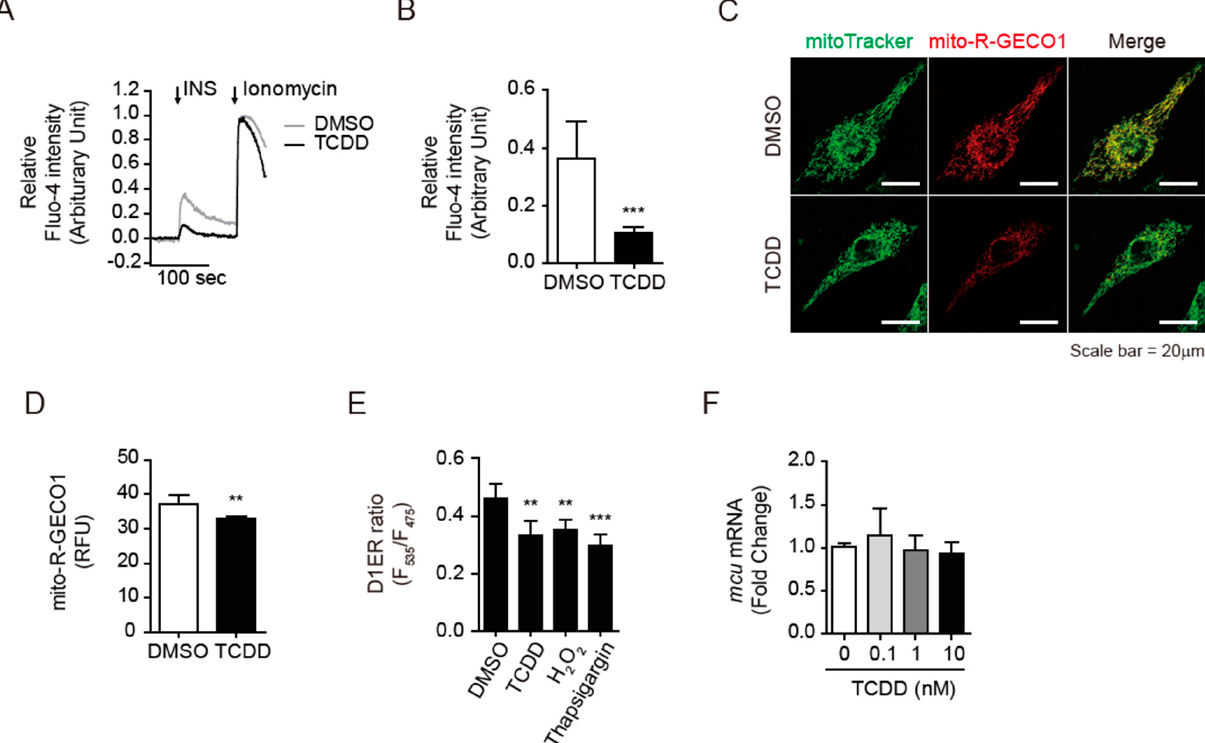
Figure 5. TCDD disturbed the insulin-triggered Ca 2+ release into the cytosol. C2C12 cells were incubated with DMSO or 100 pM of TCDD for 48 h. ( A ) Time-dependent relative Fluo-4 fluorescence intensity. The cells were loaded with 3 µ M of Fluo-4 AM for 30 min and sequentially stimulated by 100 nM of insulin and 10 μ M of ionomycin. The fluorescence was monitored by confocal microscope. ( B ) Insulin-induced calcium release. The insulin-stimulated relative fluorescence intensity was calculated from ( A ). ( C ) Confocal images. Mito-R-GECO1-transfected cells were stained with 200 nM MitoTracker™ Green for 30 min. Mitochondria (MitoTracker, green) and mitochondrial calcium (Mito-R GECO1, red) were analyzed using a confocal microscope. Scale bar = 20 μ m. ( D ) Mitochondrial calcium level. The fluorescent intensities of Mito-R-GECO1 of the cells was determined. ( E ) ER calcium. Calcium in the ER was measured using a fluorometer in D1ER-transfected cells. To verify the assay, a decrease in ER calcium was induced via incubation with 100 µ M of H 2 O 2 or 5 µ g/mL of thapsigargin for 3 h before experiment. ( F ) Real-time qRT-PCR. Relative mRNA level of MCU after TCDD treatment. Data are presented as means ± SEM ( n = 3~6). Note: ** p < 0.01, *** p < 0.001 vs. DMSO control.